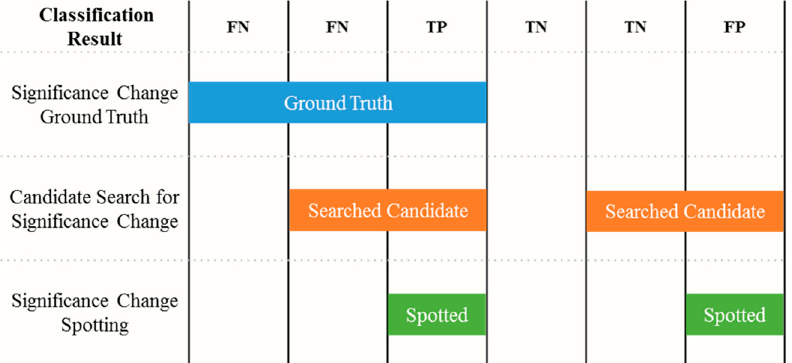
Figure 6. From bottom to top, the spotting process includes a candidate search for significant change and significant change spotting. Finally, the spotted candidates are compared against to the ground truth in terms of the classification result. If there are no searched candidates, the output of cleaning gesture must be negative.